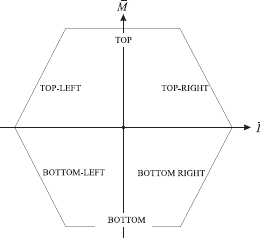
Figure 6: Borderlines appellation of the weighted admissible hexagon of { ¯ L; ¯ M